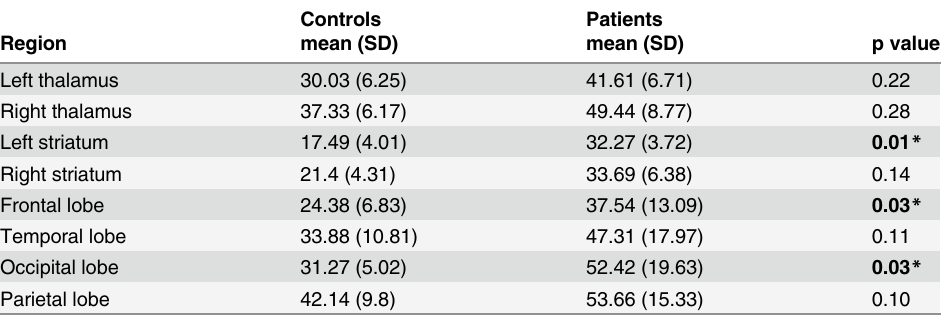
Table 3. Comparison of mean CBF values (in mL/100g/min) between control and patient groups.